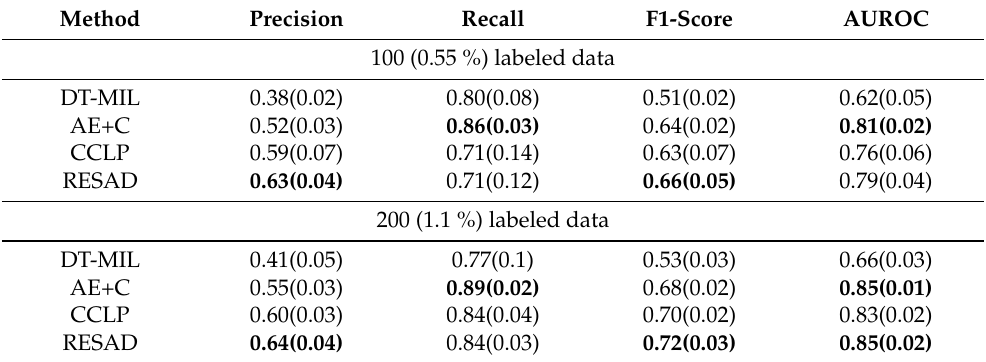
Table A1. Average performance of the models on the binarized anomaly detection problem (numbers show mean (standard deviation) based on 20 independent trials of training). Bold text shows the best performance in each